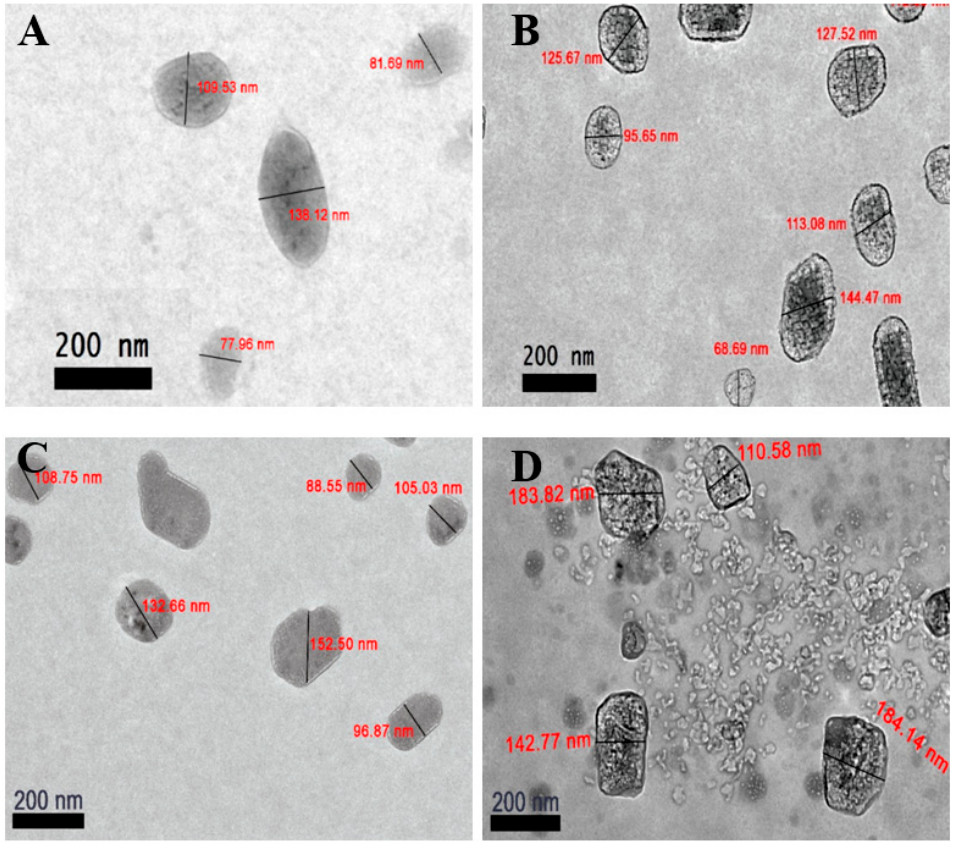
Figure 6. TEM analysis of nanoparticle samples. ( A ) CNP, ( B ) pCNP, ( C ) CNP-PCA and ( D ) pCNP-PCA. The nanoparticle samples were distributed with single-spherical like nanoparticles with uniformed dispersity with different size range.